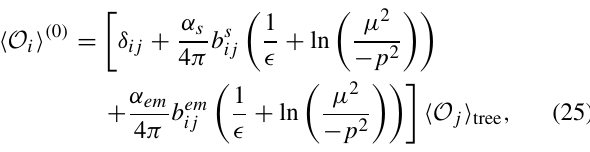
(cid:2) 1 (cid:2) 2 . See the caption of Table 2